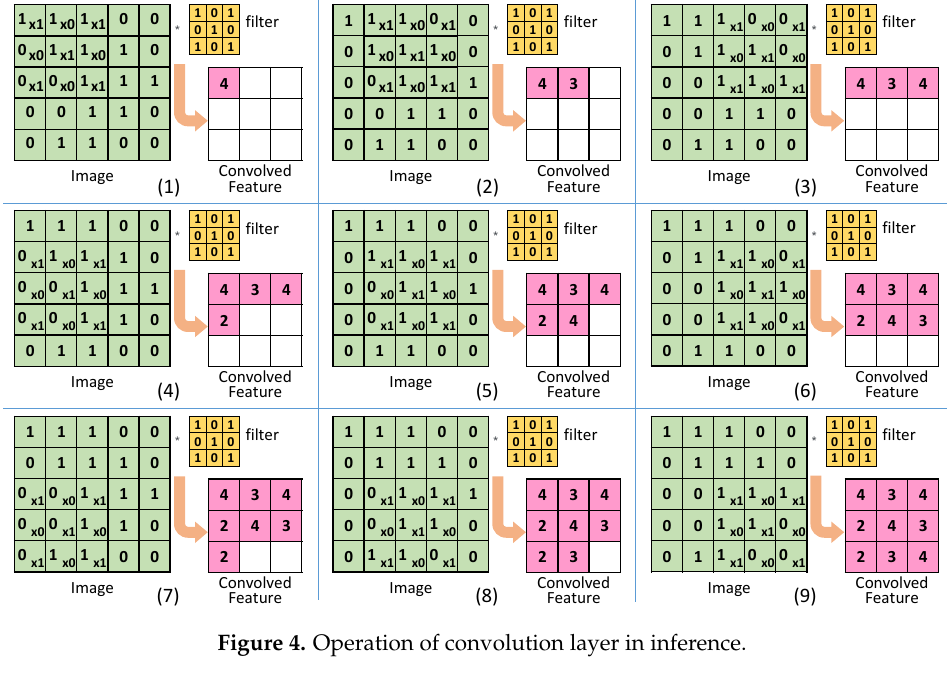
Figure 4. Operation of convolution layer in inference.